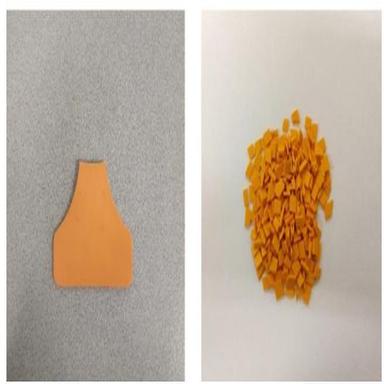
Bovine ear tag: cleaned (left) and grinded (right).